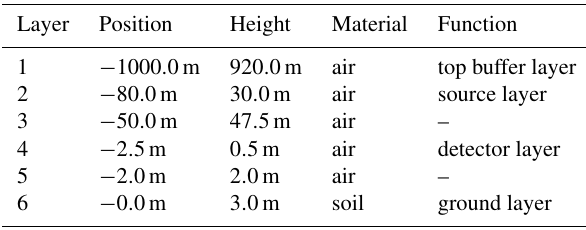
Table 3. The standard setup for a layer composition in cosmic neu- tron